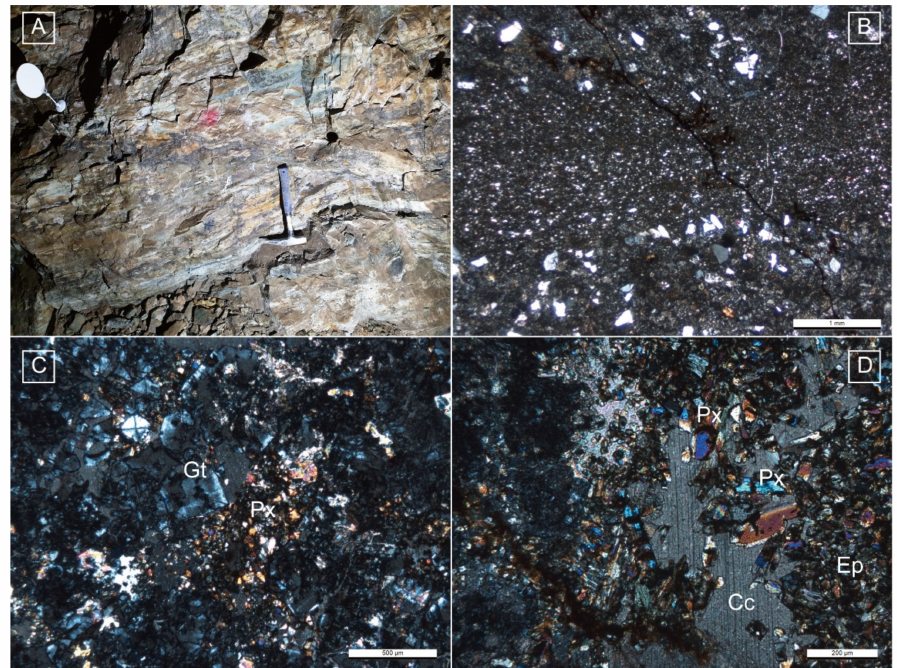
Figure 3. Hornfelsic laminated tuffaceous siltstone in the underground ( A ) and its microphoto- graph ( B ). Microphotographs of garnet skarn ( C ) and epidote skarn ( D ). ( B – D ) are under crossed nicols. ( C ) Small fragment pyroxene (Px) relics are replaced by garnet (Gt) in the garnet skarn ( C ). ( D ) Epidote (Ep) replaces calcite (Cc) and pyroxene (Px) in the pyroxene skarn ( D